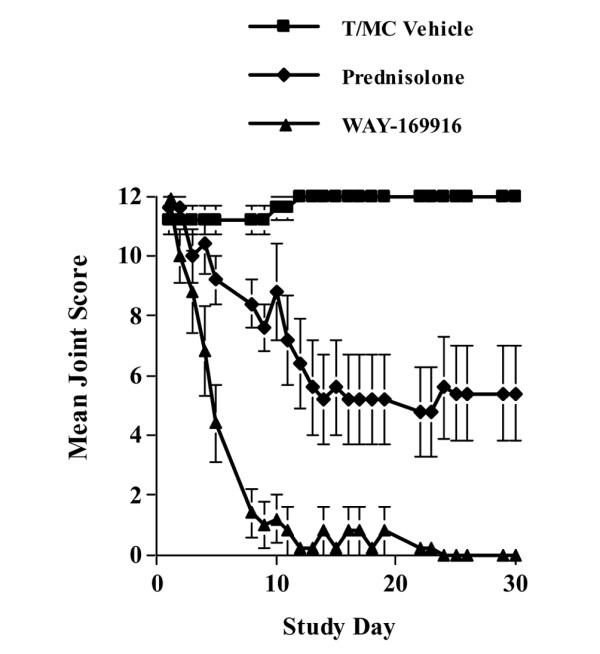
WAY-169916 improves joint scores in HLA-B27 transgenic rat model of arthritis. HLA-B27 transgenic rats, 26 to 28 weeks old, presenting signs of arthritis were treated orally daily with vehicle, prednisolone (0.6 mg/kg), or WAY-169916 (10 mg/kg) for 29 days. Joint scores were assessed by evaluating hindpaws for erythema and swelling (0 to 3 each; maximal score of 12).